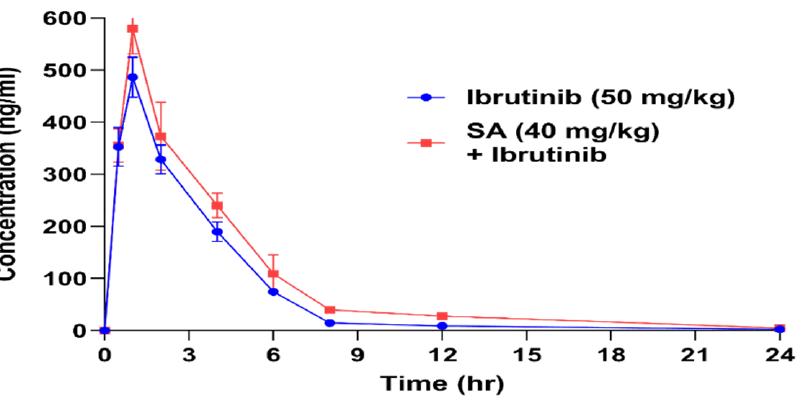
Figure 1. Plasma concentration versus time profile of IBR alone and with SA after oral administration in rats ( n = 6).